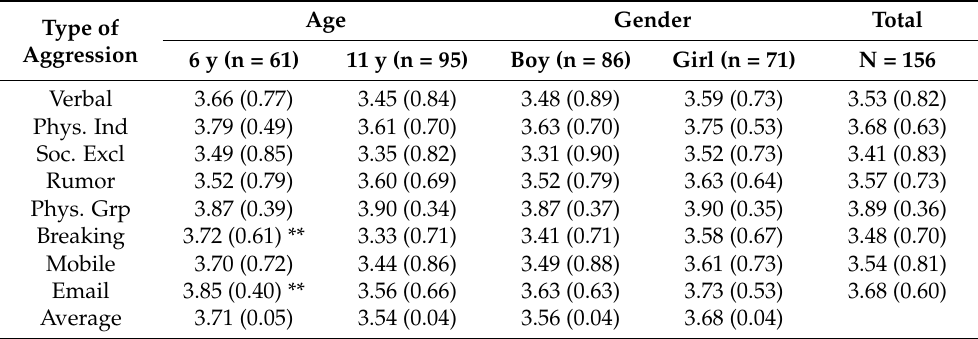
Table 3. Means (on 1–4 scale) and standard deviations of harmfulness by type of aggression, age, and gender.